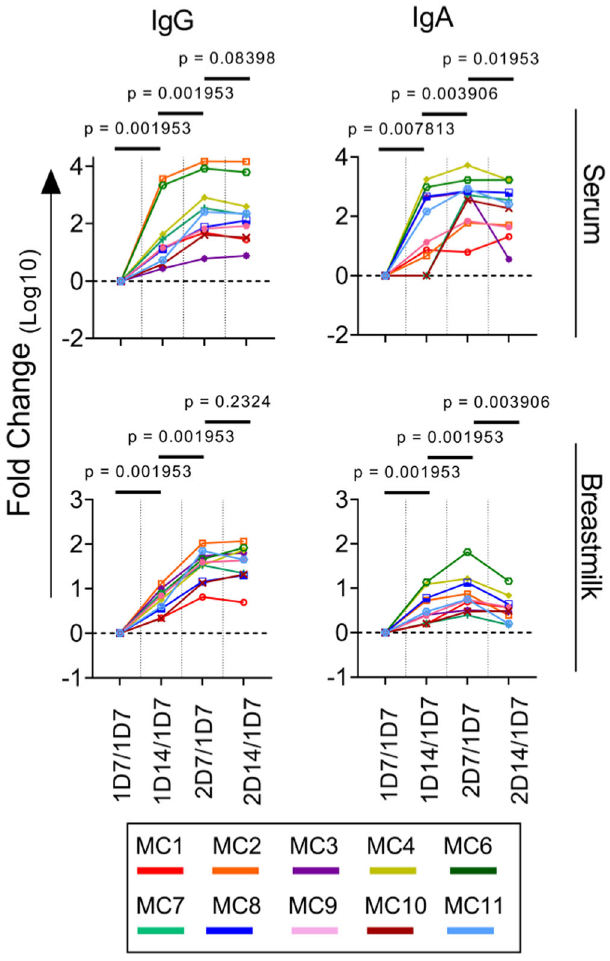
Fig. 2 Dynamics of the spike-speci fi c antibody response. Fold-changes in antibody titers compared to the fi rst time point are plotted by patient. Comparisons between the fold-change in spike-speci fi c IgG and IgA antibodies were made using the two-tailed Wilcoxon matched-paired signed-rank test; P <0.0125 was considered statistically signi fi cant following Bonferroni correction (accounting for multiple comparisons). Y -axis units are fold-change on a logarithmic scale. Source data are provided as a Source Data fi